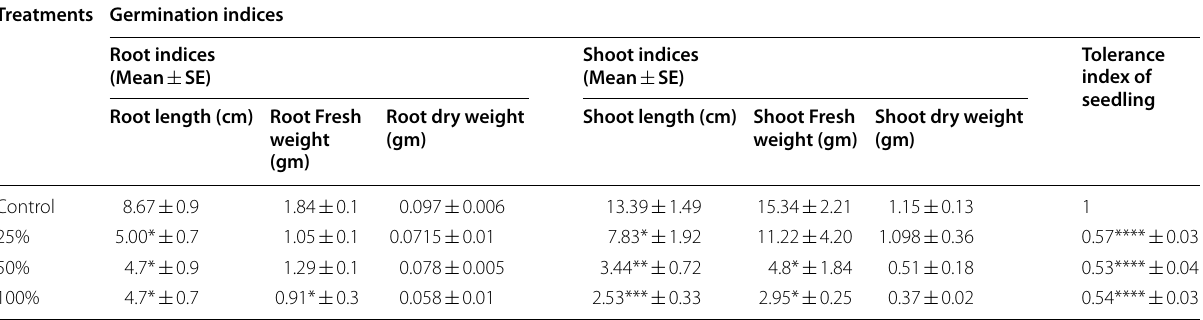
*, **, *** and **** Significant at 0.05, 0.01, 0.001 and 0.0001 probability levels, respectively